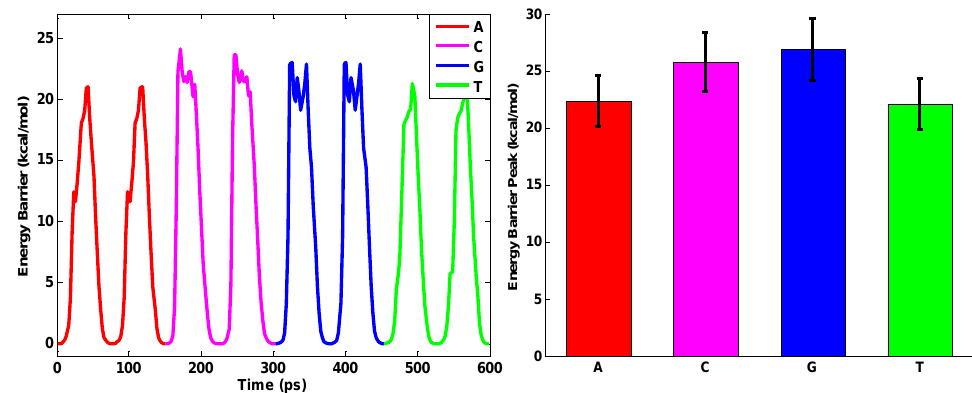
Figure 8. Energy profile when ssDNA passes through the elliptical hBN nanopores. The energy peak values for different nucleotides are extracted from the energy profile.